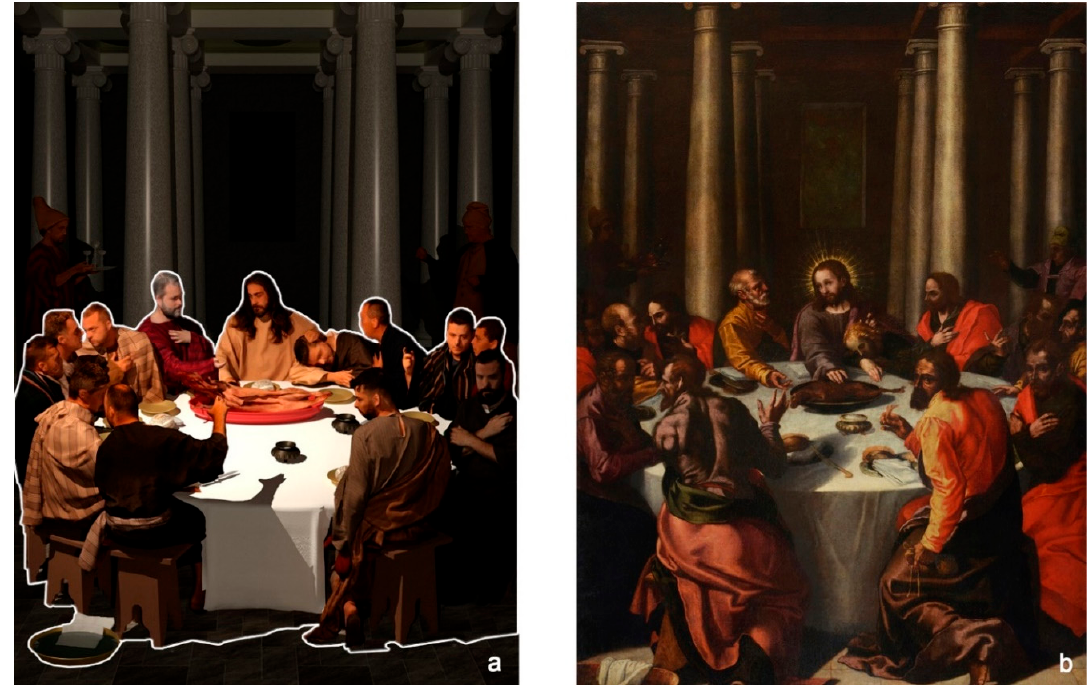
Figure 17. ( a ) Overlay of image 17d on image 17c; ( b ) G. Hovic, Last Supper.